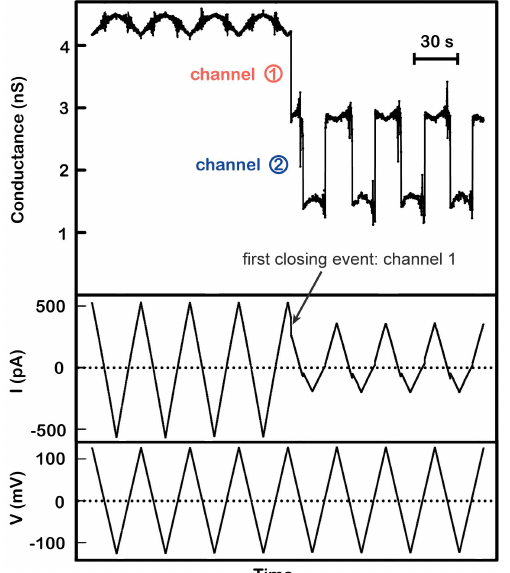
Figure 2. Positive cooperativity between channel 1 and 2. A single triplin (4.4 nS) was probed using a 30 mHz (7.4 mV / s) triangular voltage ramp ( ± 124 mV). From top to bottom, the panels are the calculated conductance, the current (in picoAmperes, pA), and the applied voltage traces. Closure of channel 2 at negative potentials only occurred after closure of channel 1 at a high positive potential (here at + 98 mV). Channel 2 closure and reopening occurred in all subsequent voltage ramps. Note that in the absence of gating the conductance varies somewhat with voltage due to a small amount of rectification in these